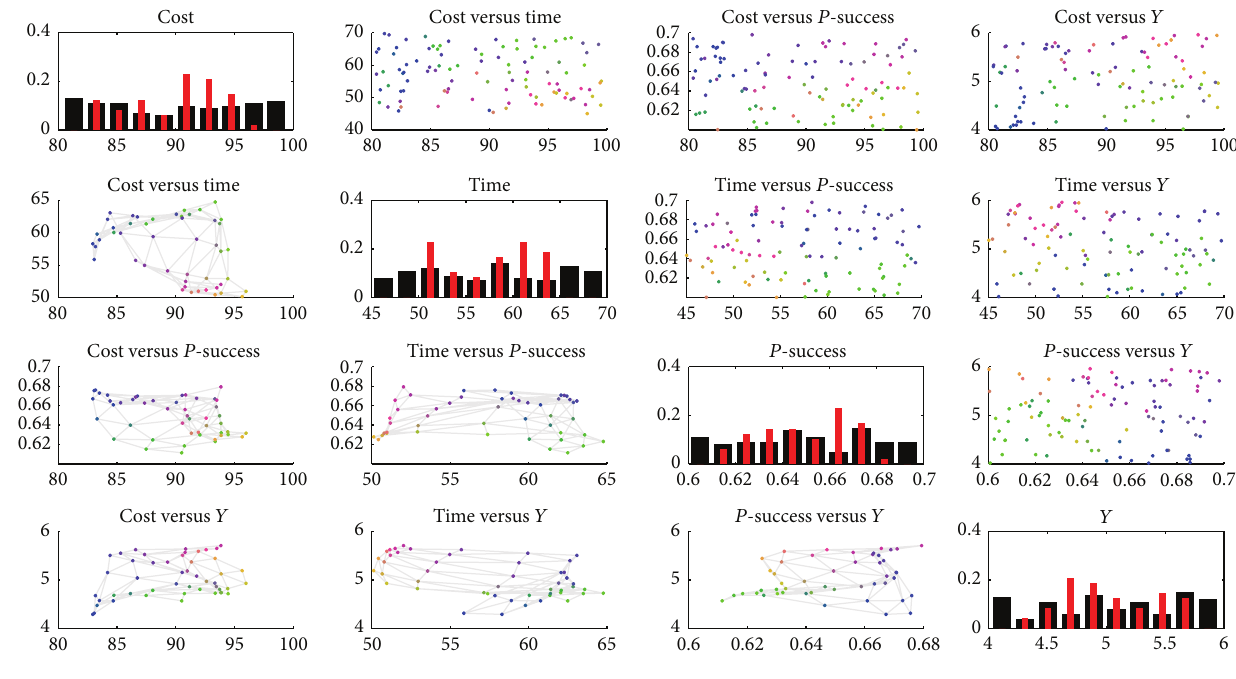
Figure 4: The SOM result II.